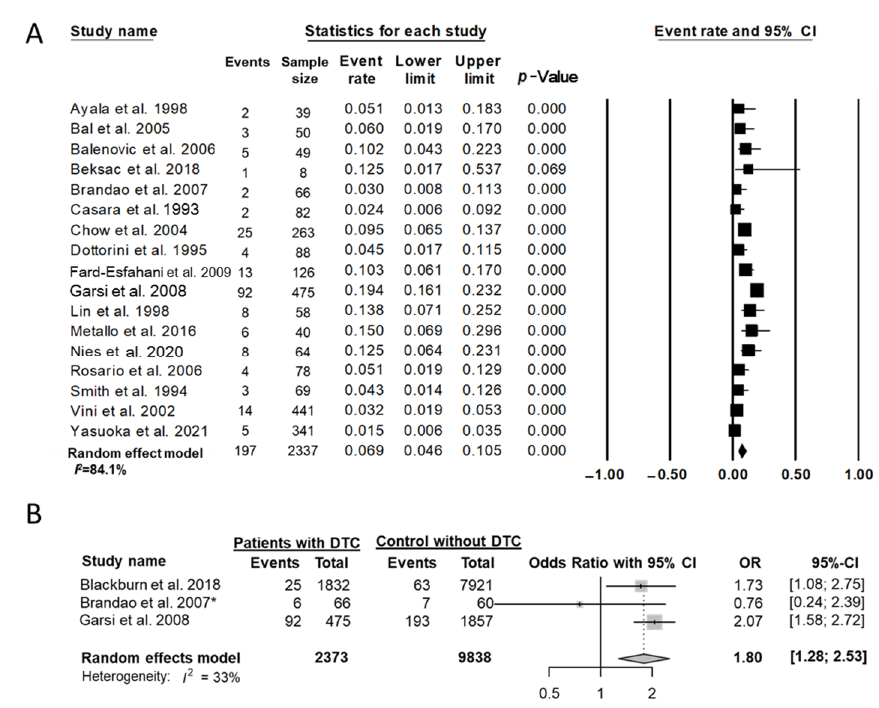
Figure 2. Effect of treatment of differentiated thyroid cancer on miscarriage. ( A ) Event rate among cases of pregnancy and ( B ) the OR between patients with DTC and controls without differentiated thyroid cancer; * abortion. Studies referenced in the figure are: [21,22,25,26,28–37,39–42].